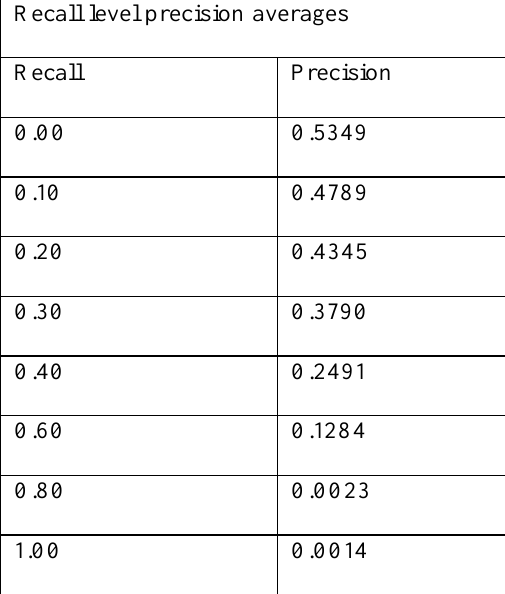
Recall and Precision Table for Generated SQL Recall level precision averages